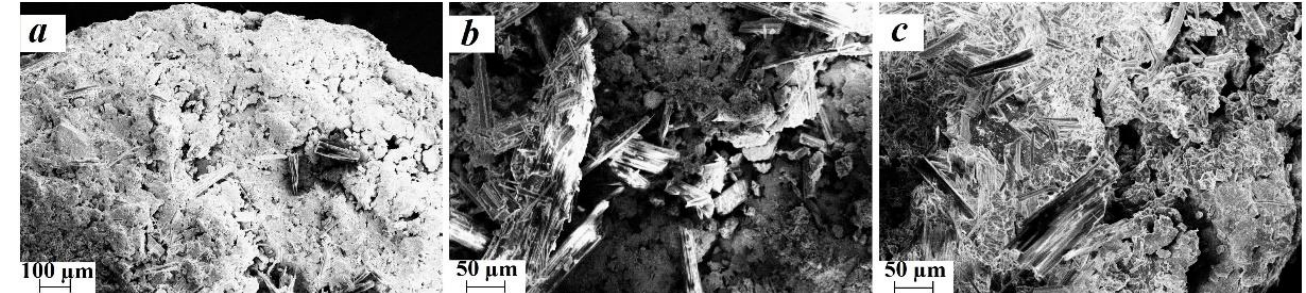
Figure 4. SEM images of the morphology ( а ) and the granule surface of copper-nickel tailings after storage for 180 days at +19 °С ( b , c ).